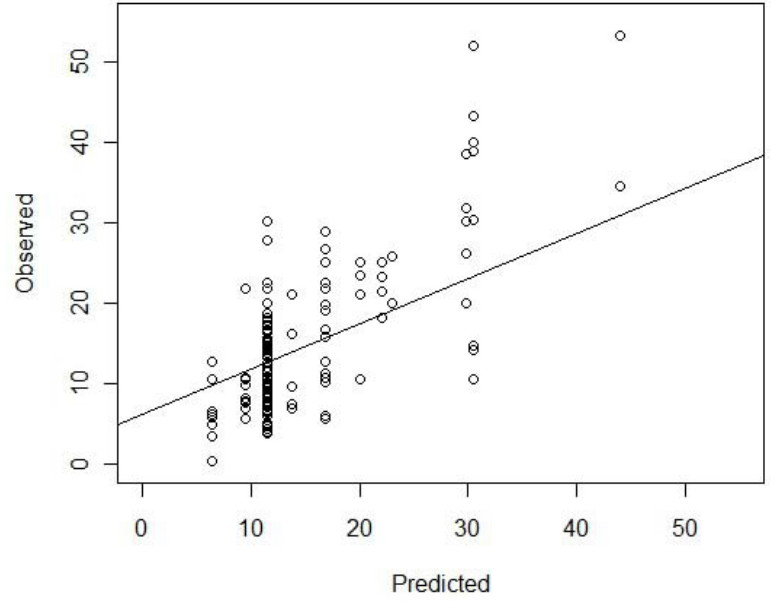
Figure 2. Plot of observed versus predicted values of a model that predict herbaceous richness in pine forest of the southeastern coastal plain.